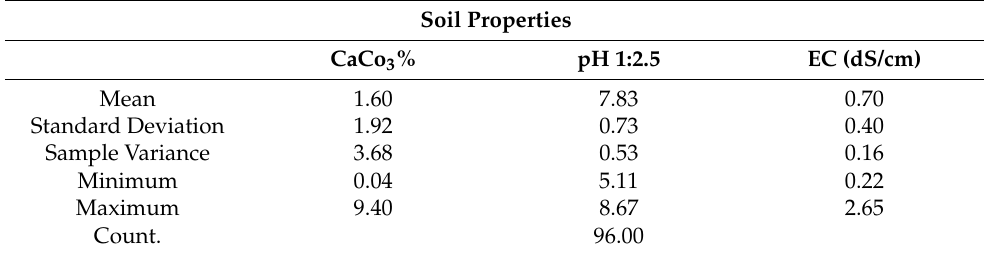
Table 2. Soil properties descriptive statistics data.